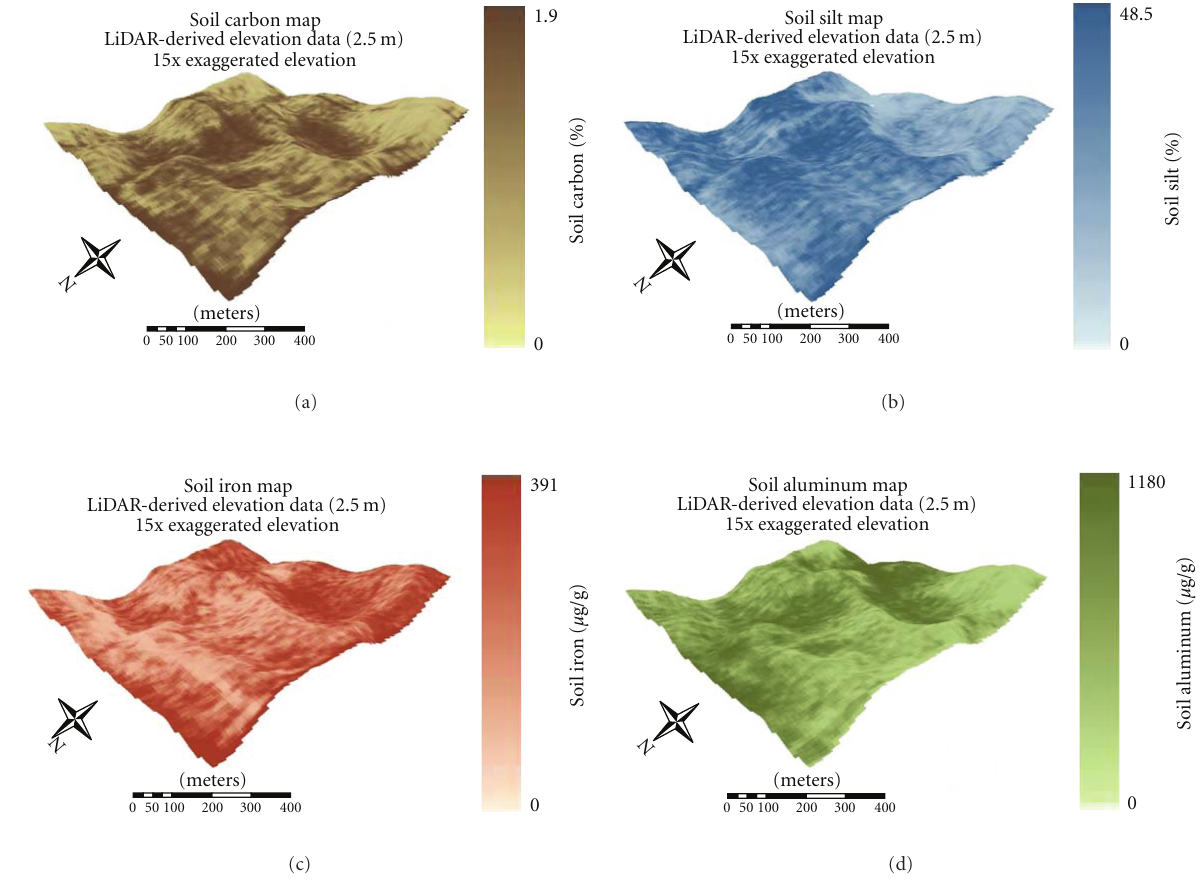
Figure 4: Map of predicted values for select analytes (C, Silt, Fe, Al), overlaid on a high-resolution digital elevation map, for one of the six sampled fields (Mason). Predicted values were derived from imagery that had been smoothed with a 3 × 3 low pass